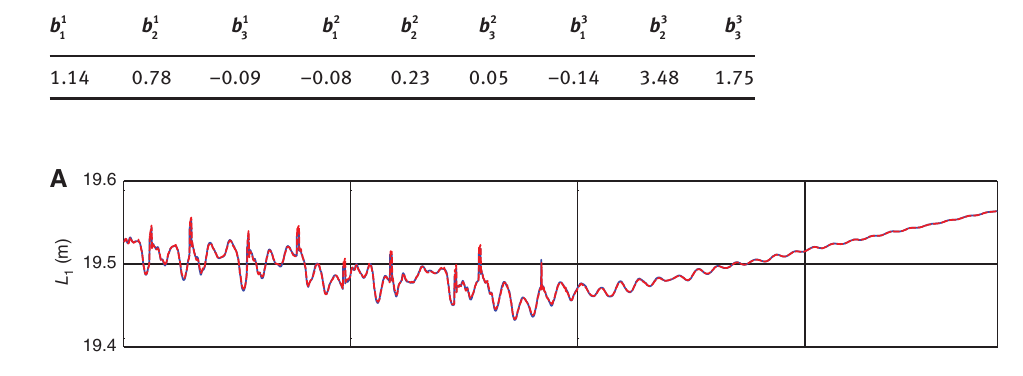
Figure 10. Scenario 1. Estimated (Red Dashed Line) and Measured (Blue Continuous Line) Levels at (A) Cuinchy L la-Lys L , and (C) Fontinettes L 2